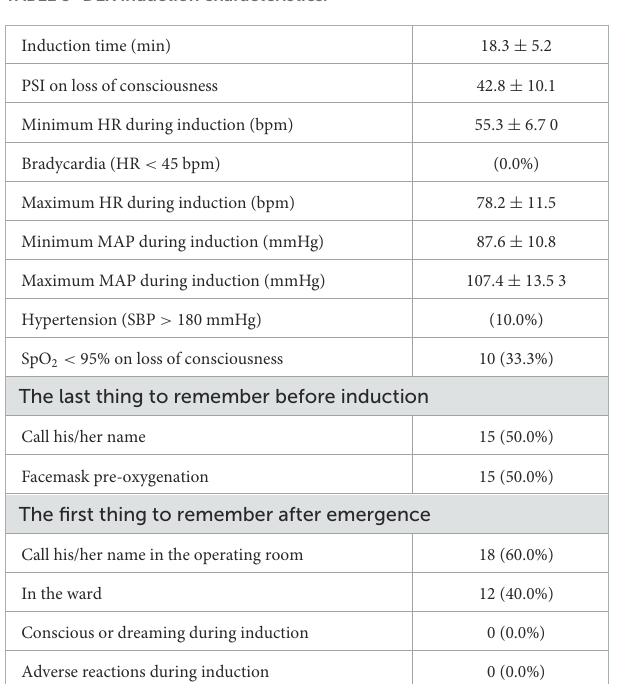
TABLE 3 DEX induction